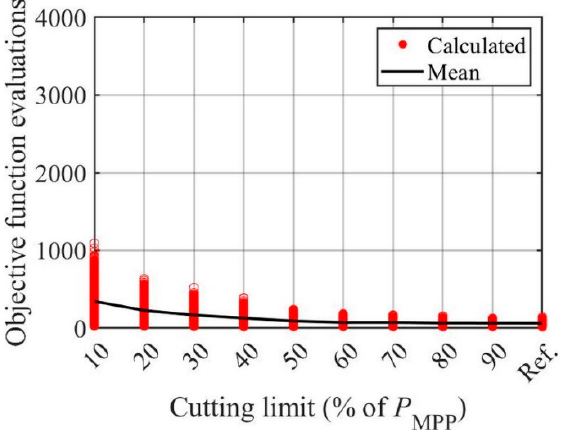
Figure 11. Objective function evaluations needed for fitting during the 40 min measurement period as a function of the cutting limit based on MPP power.